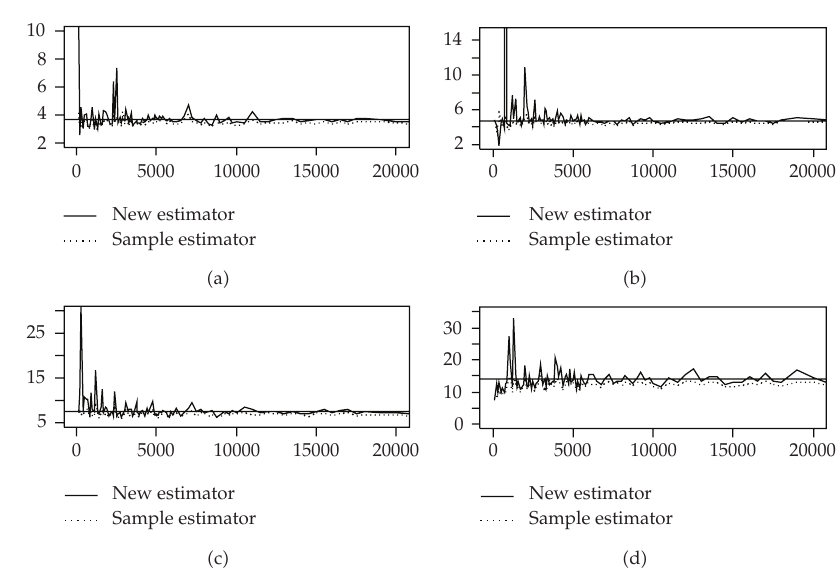
(cid:8) Figure 1: Values of the CTE estimator CTE n (cid:2) t (cid:3) (cid:2) vertical axis (cid:3) versus sample sizes n (cid:2) horizontal axis (cid:3) evaluated at the levels t (cid:7) 0 . 25, t (cid:7) 0 . 50, t (cid:7) 0 . 75, and t (cid:7) 0 . 90 (cid:2) panels (cid:2) a (cid:3) – (cid:2) d (cid:3) , resp. (cid:3) in the Pareto case with the tail index γ (cid:7) 2 /